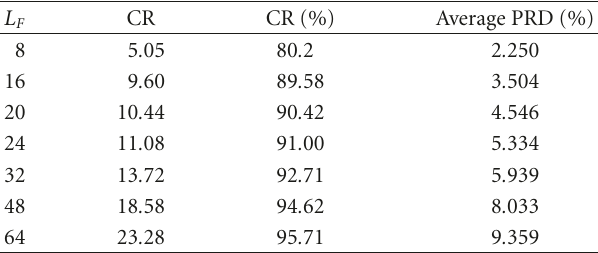
Table 2: CR and average PRD associated with PSEVS for di ff erent frame